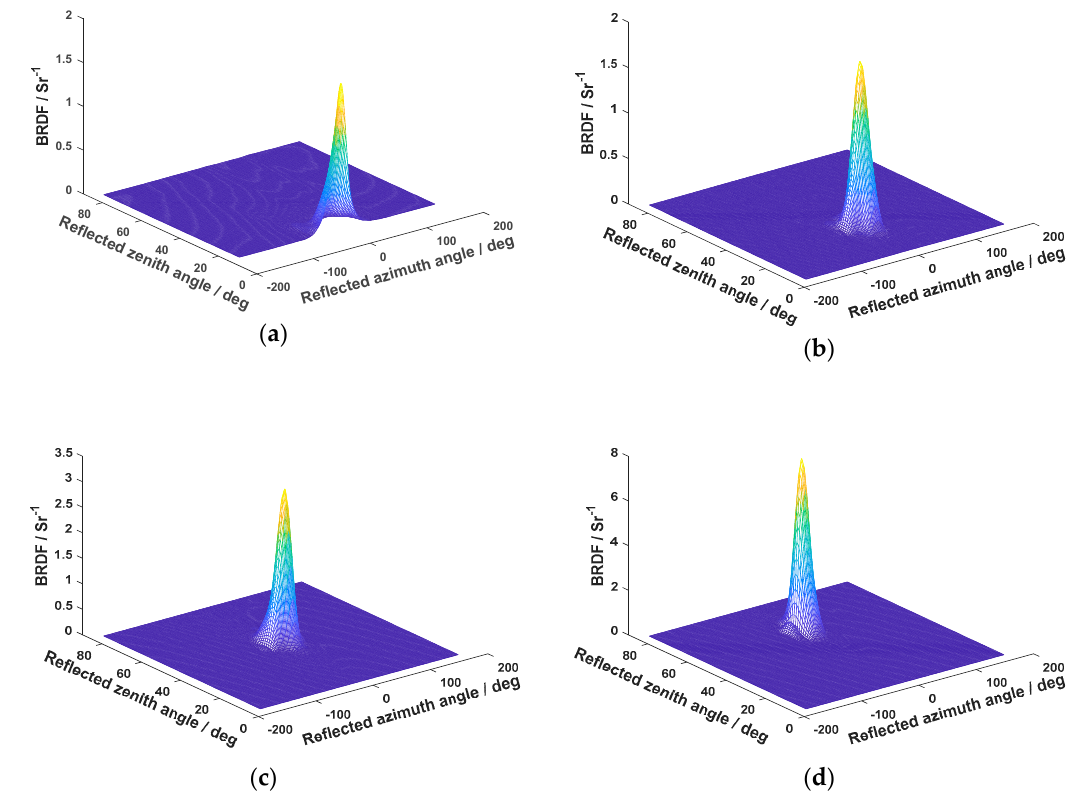
Figure 11. BRDF distribution of solar panel. ( a ) θ i = 15 ◦ ; ( b ) θ i = 30 ◦ ; ( c ) θ i = 45 ◦ ; ( d ) θ i = 60 ◦ .